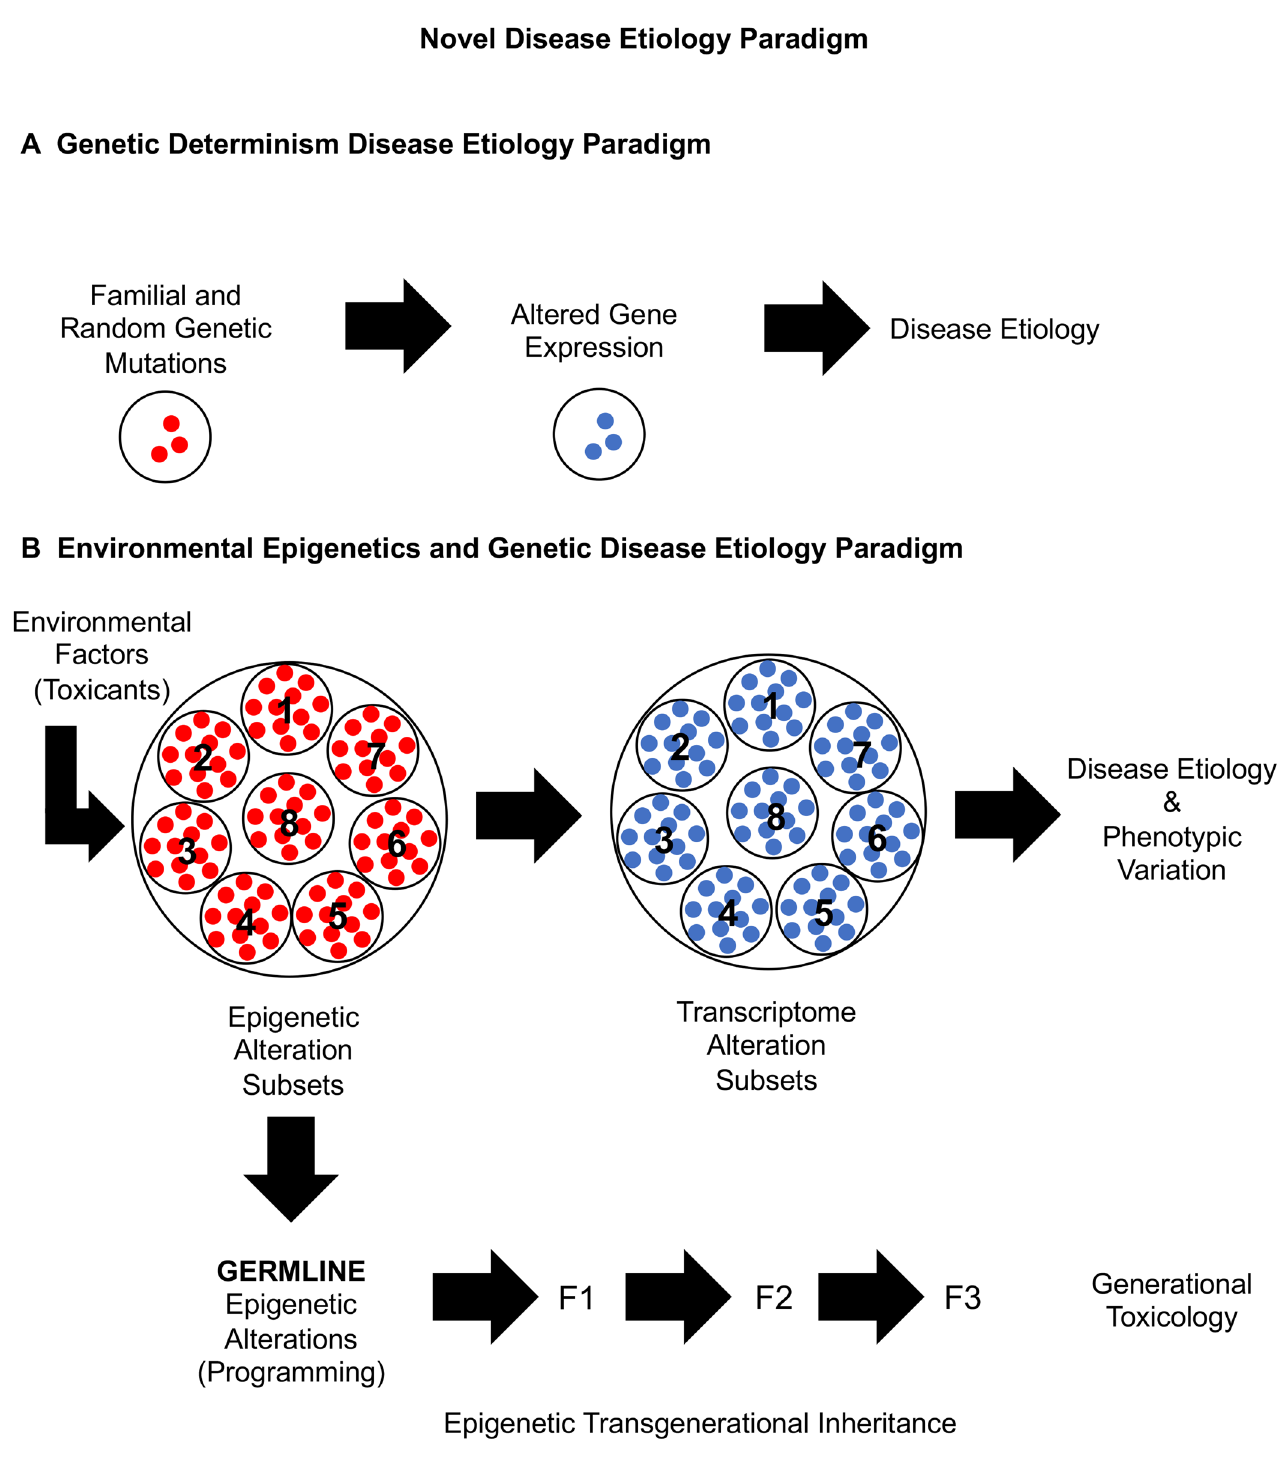
Figure 7. Novel disease etiology paradigm. ( A ) Genetic determination disease etiology paradigm. ( B ) Environmental epigenetics and genetic disease etiology paradigm. Environmental exposures promote subsets of distinct subsets of DMR associated sites that are associated with subsets of DMR linked genes that when altered promote disease etiology and phenotypic variation. The subsets of altered epimutations are transmitted to subsequent generations through the germline to promote generational